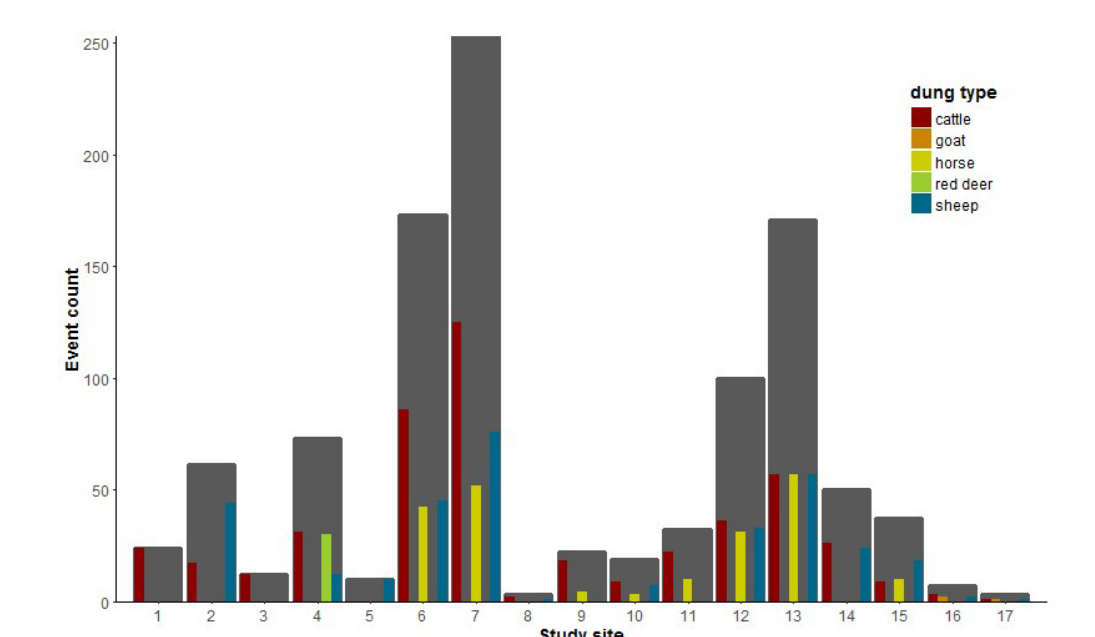
Figure 5. Total number of sampling events of dung beetles by study site (grey bars) and by dung type (coloured bars). Study site codes correspond with the codes in the map of Figure